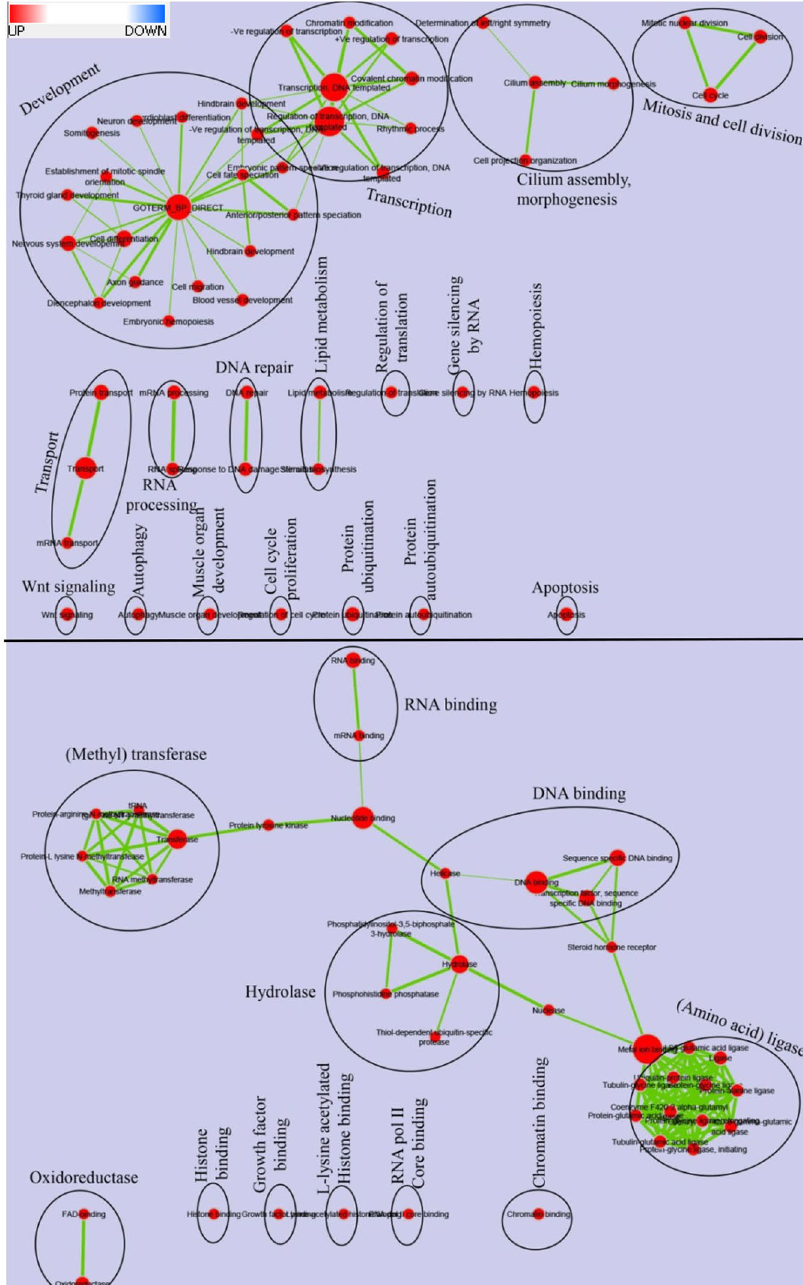
Figure 3. Enrichment map and enriched gene pathways of predicted microRNA targets classified into the biological process (top) and molecular function (bottom) categories. In enrichment map, enriched gene-sets represent nodes, which are related/connected by their GO relation(s) (edges). Red node color represents enriched gene-set. Color intensity of the node represents significance of enrichment; node size represents number of genes in the gene-set (proportional relation) and edge thickness represents degree of overlap between gene-sets (proportional relation). Note: Same node size in molecular function and biological process category does not include the same number of genes because maps are generated separately and then